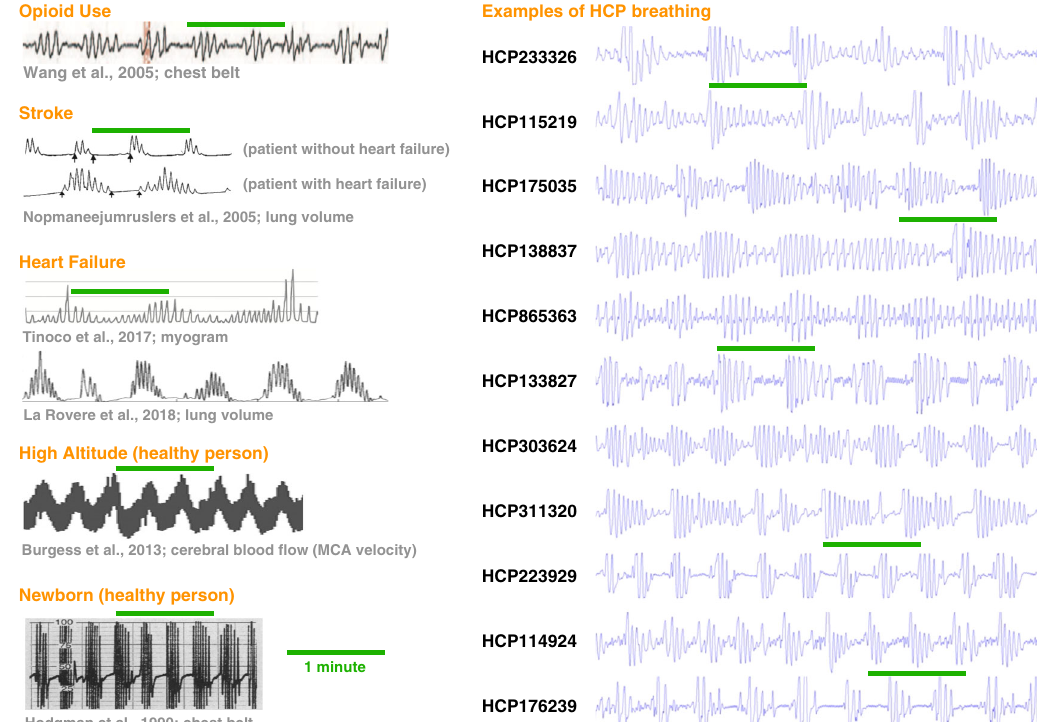
Fig. 7 Comparison of periodic breathing waveforms and bursts. At left, single-subject waveforms of periodic breathing in opioid use, stroke, heart failure, at high altitude, and in newborns. These are all conditions and situations in which periodic breathing is commonly encountered. At right, illustrations of bursts in 11 HCP subjects. All plots are on the same time scale, and the green lines measure 1 min. Note the long cycle times seen in patients with heart failure (in the Stroke and Heart failure sections), re fl ecting, in part, an exaggerated delay in central detection of changes in arterial gas tensions (see Supplementary Discussion for more detail). The stroke example illustrates shows the added effect of delayed circulatory time in heart failure. Images at left modi fi ed from 46,54 – 58 with permission. Images from ref. 55 adapted with the permission of the American Thoracic Society. Copyright © 2020 American Thoracic Society. All rights reserved. The American Journal of Respiratory and Critical Care Medicine is an of fi cial journal of the American Thoracic Society. Readers are encouraged to read the entire article for the correct context at https://europepmc.org/article/med/15665317. The authors, editors, and The American Thoracic Society are not responsible for errors or omissions in